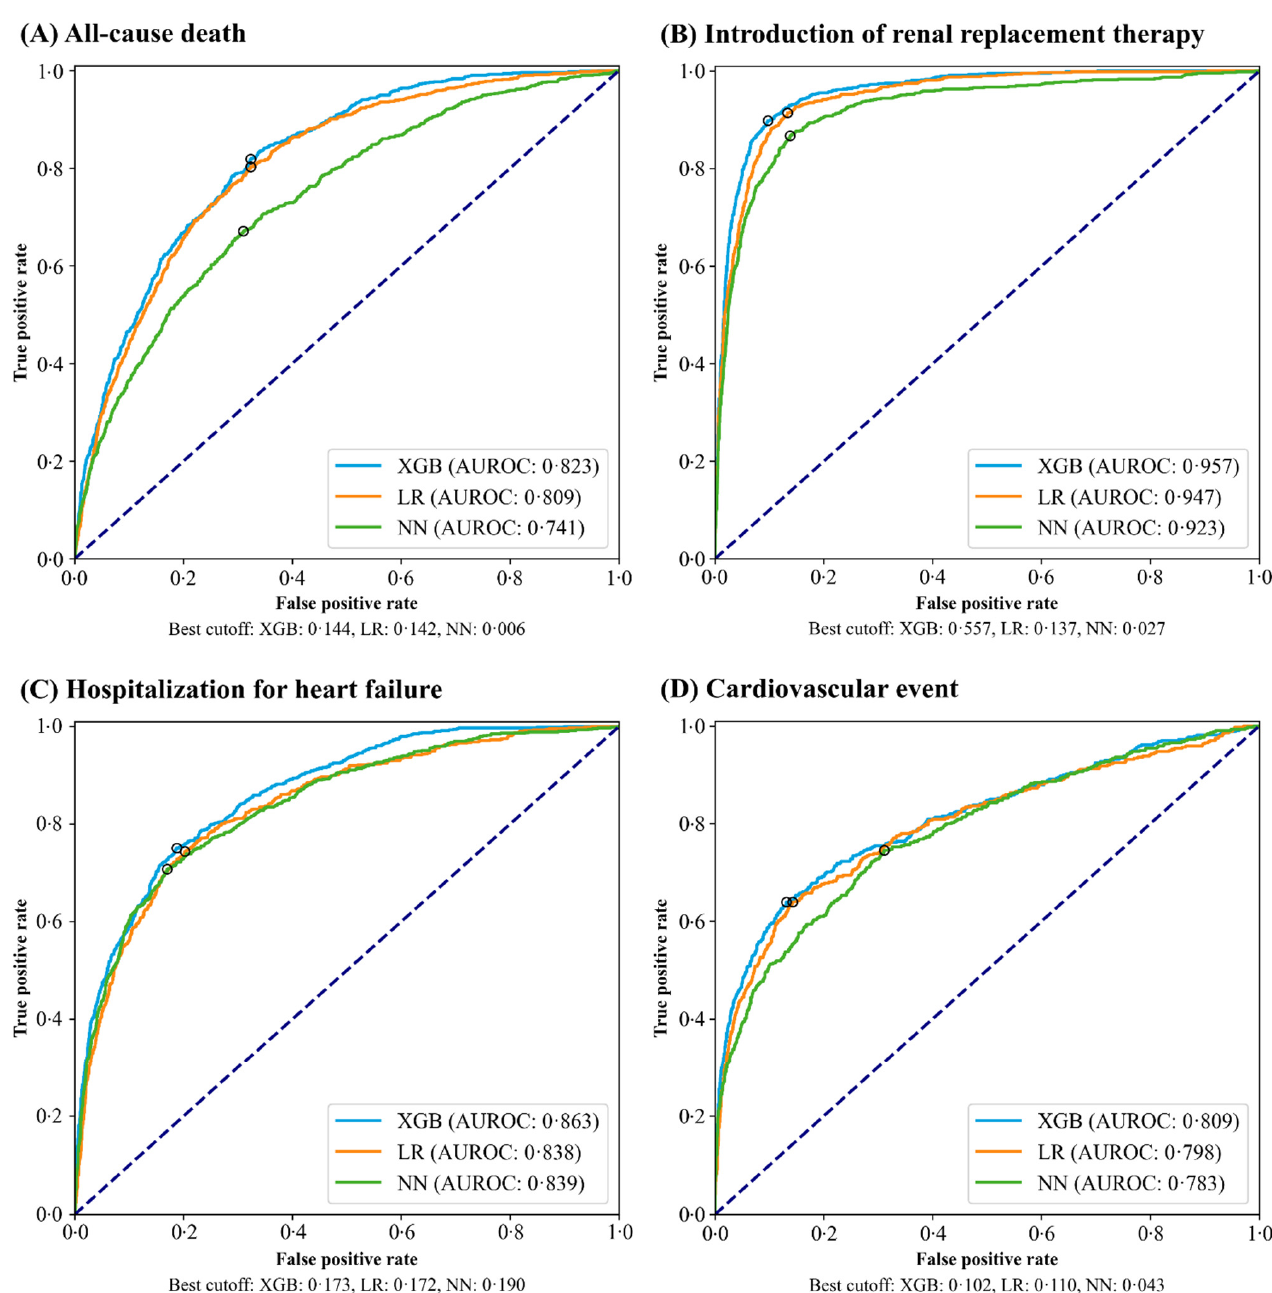
Figure 2. Receiver operator characteristics curves evaluated on the internal validation set. The black rings on each plot show the best-cut off values. XGB, extreme gradient boosting; LR, logistic regression; NN, neural network; AUROC, area under the operator receiver characteristics curve.